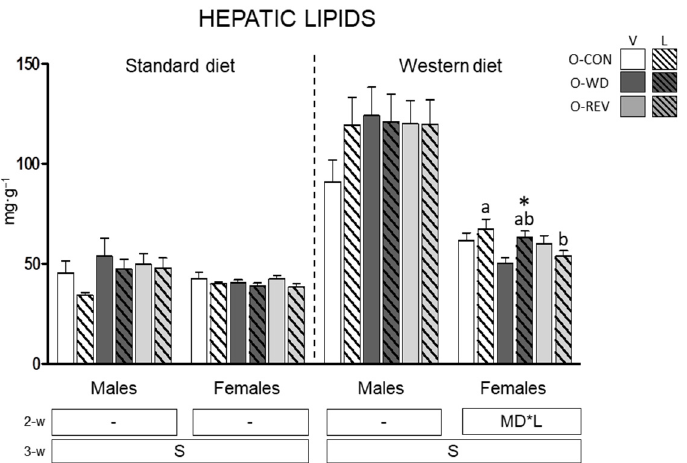
Figure 5. Hepatic lipid content in O-CON, O-WD and O-REV male and female animals treated with vehicle or leptin during suckling and fed SD or WD from weaning, at four months of age. Data are mean ± SEM ( n = 8–12). Statistics: After data separation depending on post-weaning diet, three-way ANOVA was performed to analyze the effect of sex, maternal diet and/or leptin treatment. In each sex, two-way ANOVA was performed to analyze the effect of leptin treatment and/or maternal diet. When an interactive effect was found, one-way ANOVA was performed to analyze the effect of maternal diet in each treatment. Single comparisons between leptin versus vehicle-treated rats of all experimental groups were carried out using Mann-Whitney U test. Symbols: sex (S), maternal diet (MD), leptin treatment (L); a (cid:54) = b ( p < 0.05, LSD post-hoc, one-way ANOVA); *, different from their vehicle-treated equal ( p < 0.05, Mann-Whitney U test). Abbreviations: offspring of